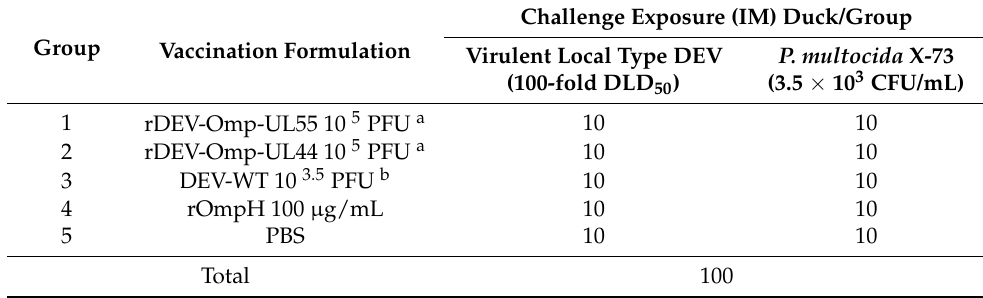
Table 1. Vaccine immunization and challenge exposure in duck.